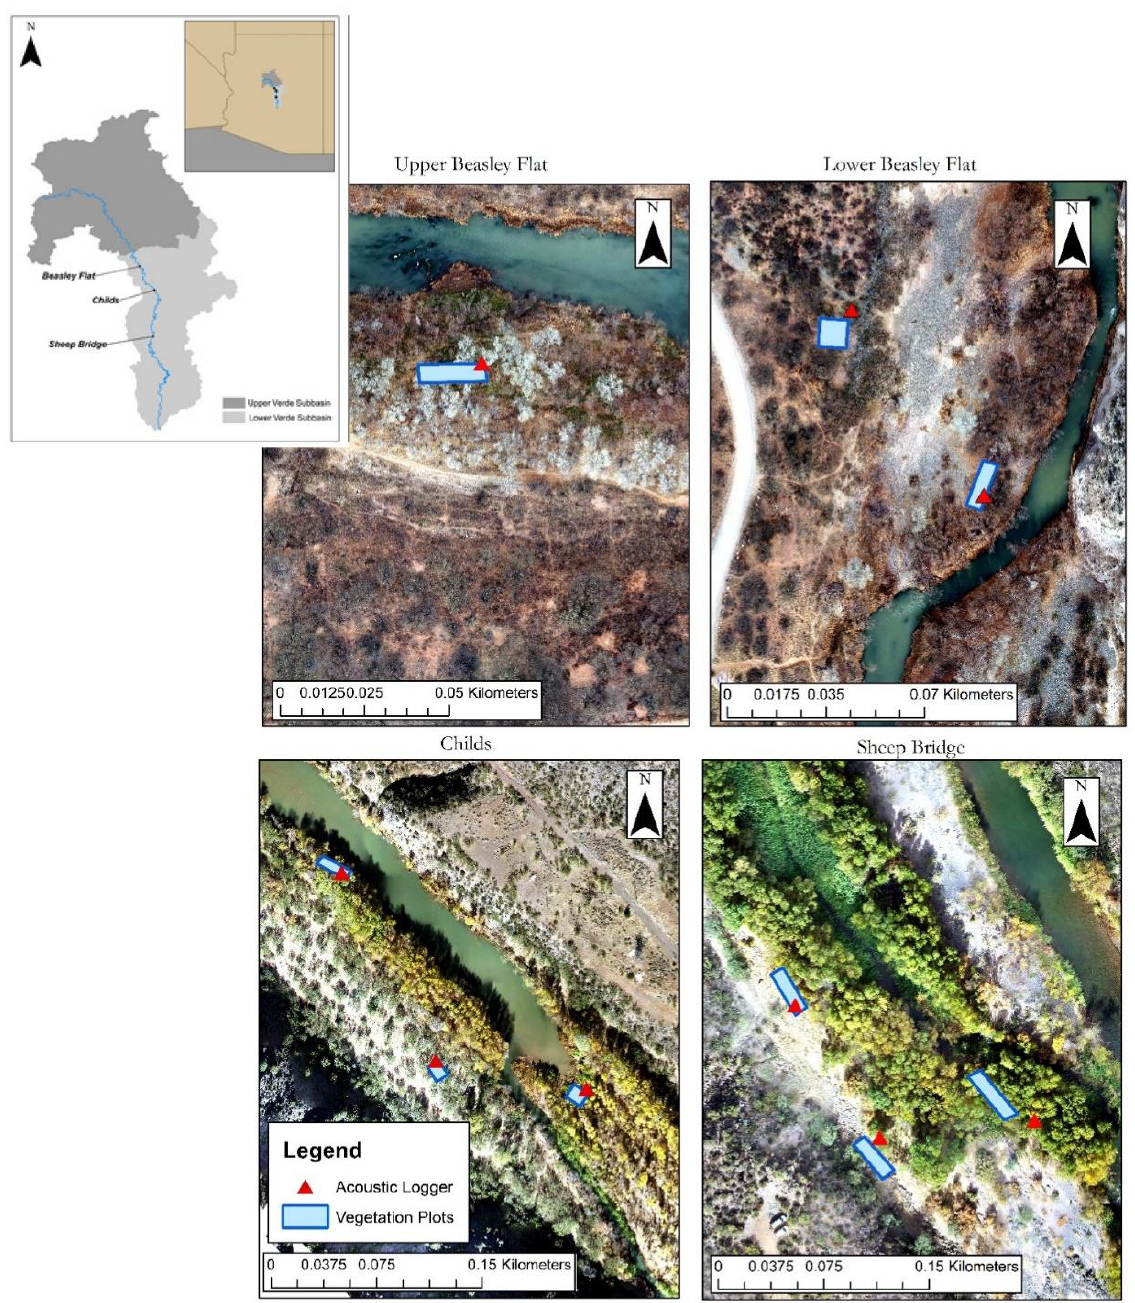
Figure 1. Study reaches (Beasley Flat, Childs, Sheep Bridge) along the Lower Verde River, Arizona (USA). Passive acoustic recorders stratified across a range of habitat complexities defined in Cubley et al. [42]. Habitat measured in 100 m 2 plots and from UAV images.